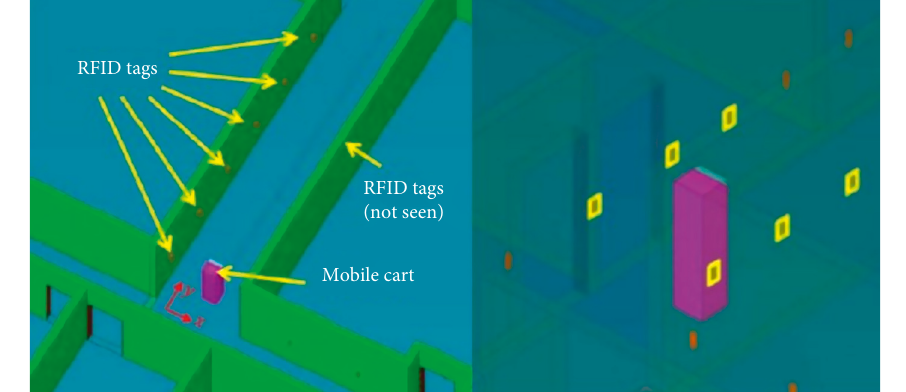
Figure 2: IfcRfidSystem entity EXPRESS-G view.